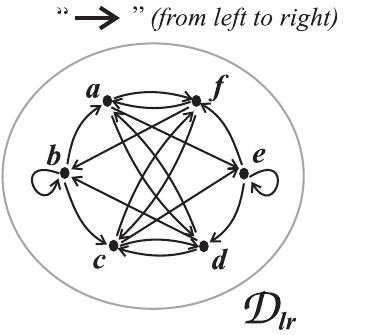
Figure 7. Six possible situations in any vertex for a given 2-factor.